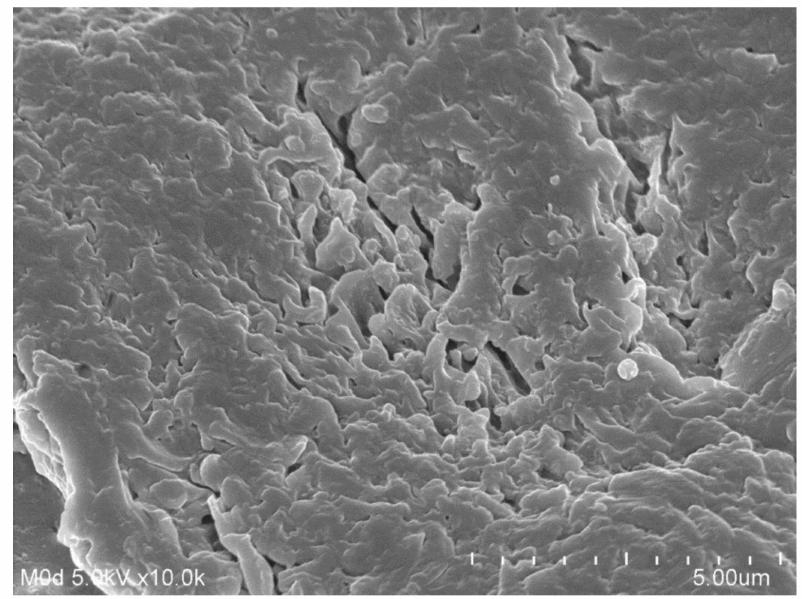
Figure 5. Scanning electron microscopy of GAcPAAc